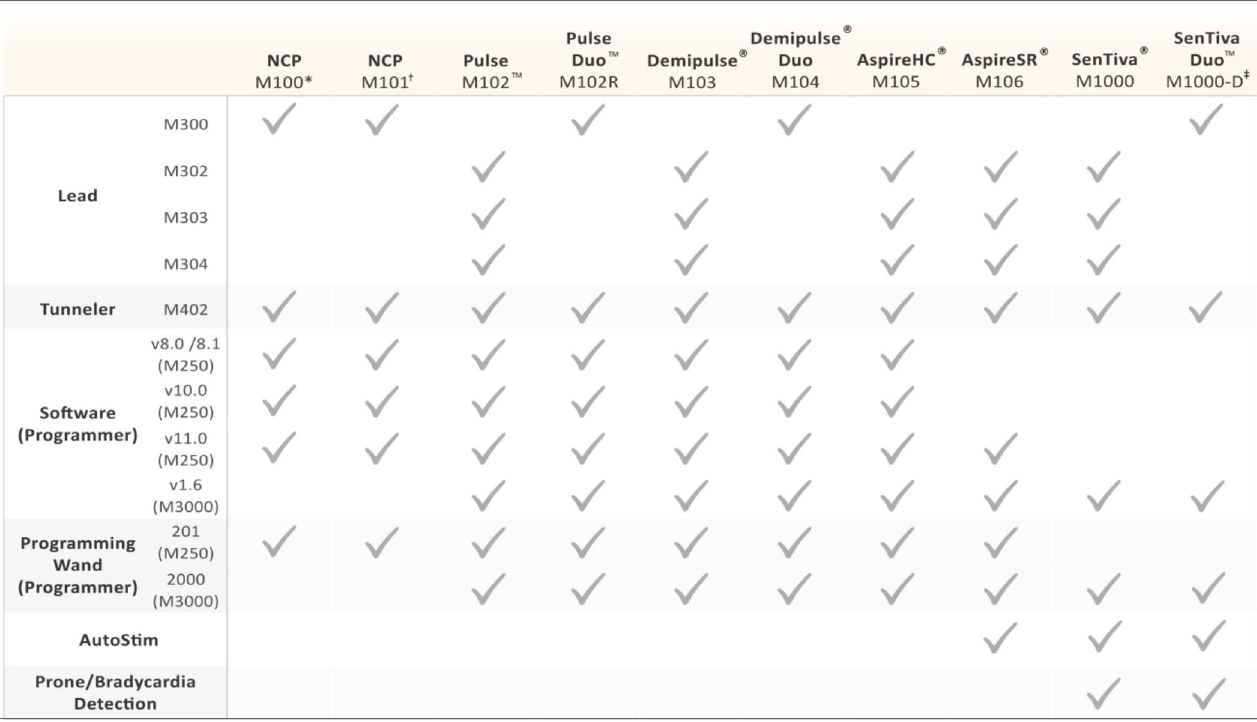
TABLE 2 | Compatibility of VNS Therapy